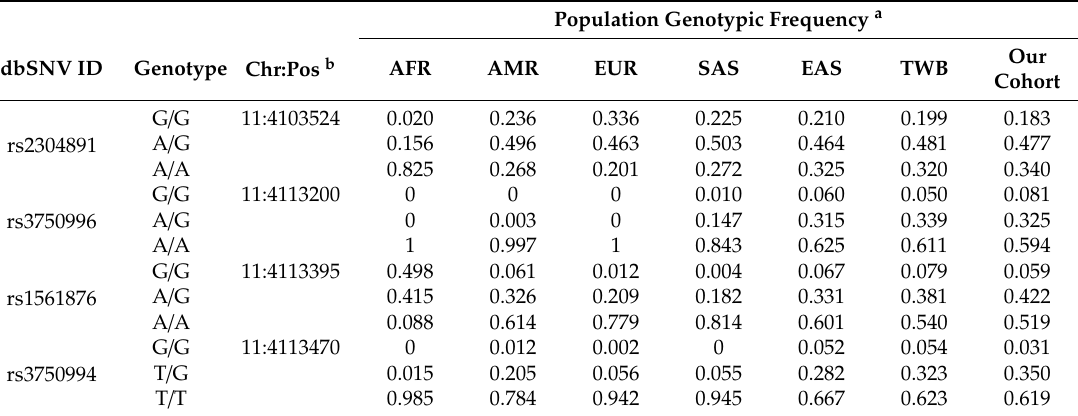
Figure 2. Graphical overview of the human STIM1 gene and 4 tagging SNVs in this study. Table 2. Genotype frequencies of STIM1 germline variants in di ff erent ethnic populations.